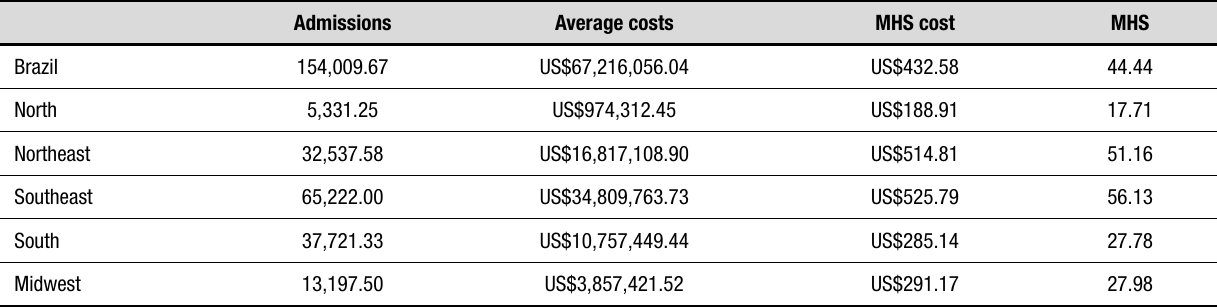
Table 1. Admissions, costs and hospital days during 2008–2019 in Brazil.